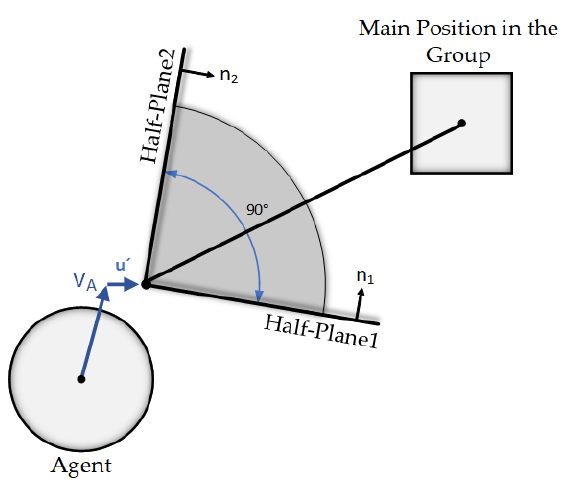
Figure 3. Producing additional half-planes in the direction of the proper location, in each time step of the algorithm.